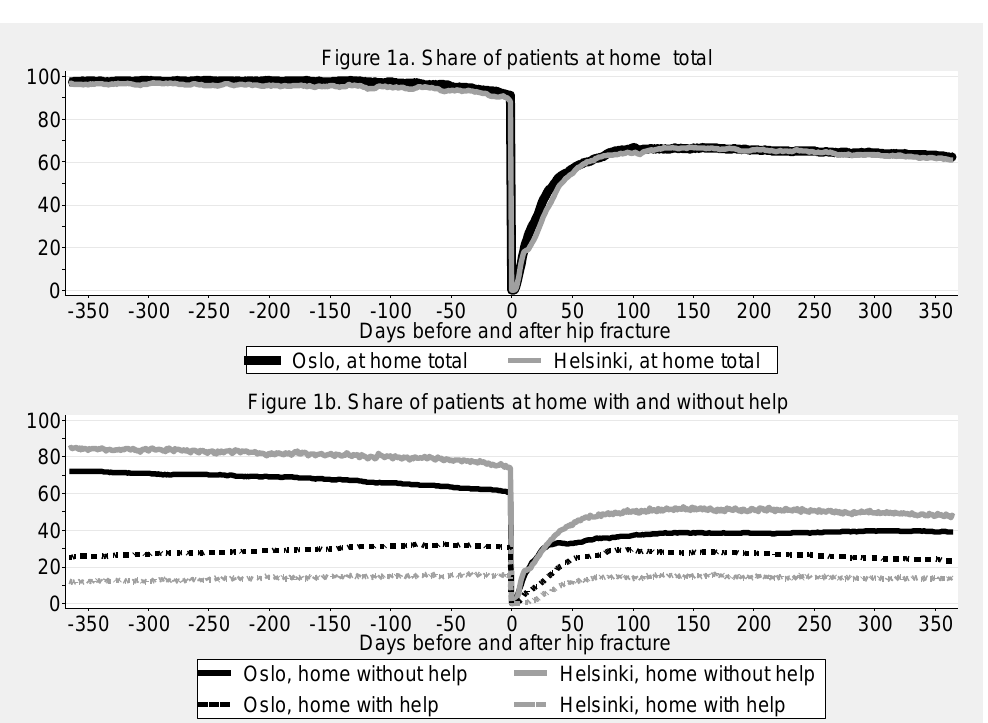
Share (%) of patients at home with and without help before and after hip fracture, 2009–2013 Figure 1a. Share of patients at home